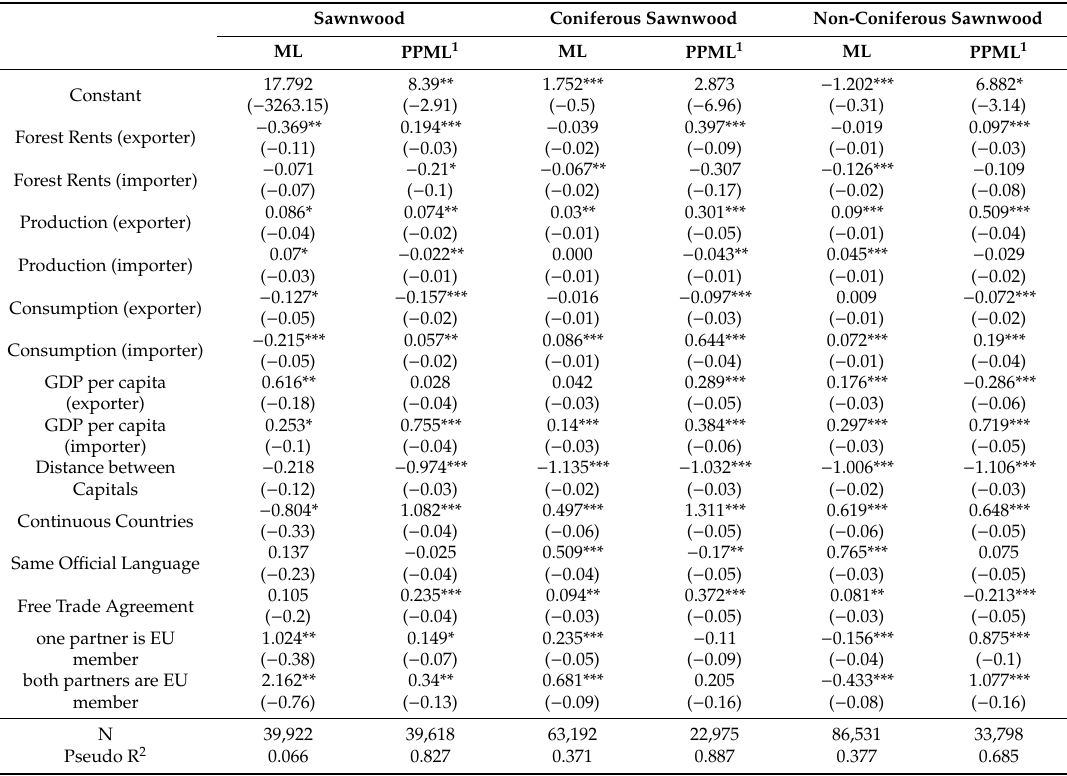
Table A3. Estimation results for the product group